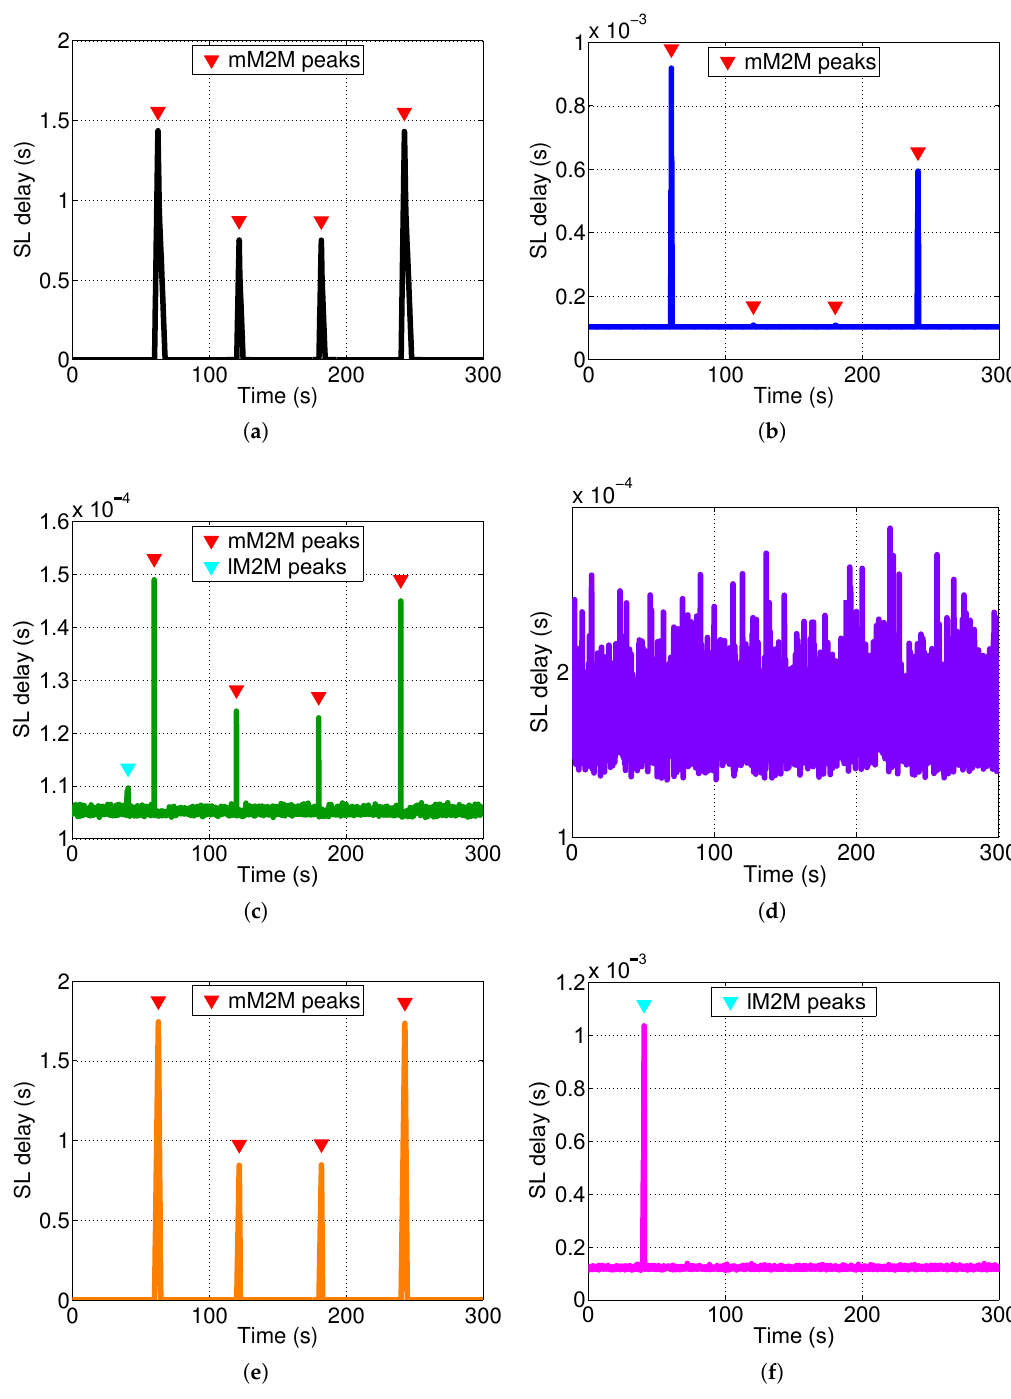
Figure 12. SLs’ filtered processing time for each scheme (ten M2M devices per MBB UE). ( a ) Baseline scheme; ( b ) Overdimensioned scheme; ( c ) Traffic shaper scheme; ( d ) Traffic separated scheme: MBB class; ( e ) Traffic separated scheme: mM2M class; ( f ) Traffic separated scheme: lM2M